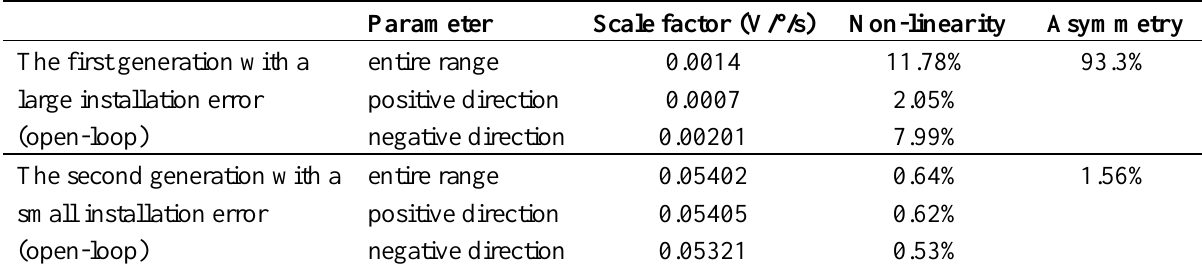
Table 4. Scale factor comparison test in different installation